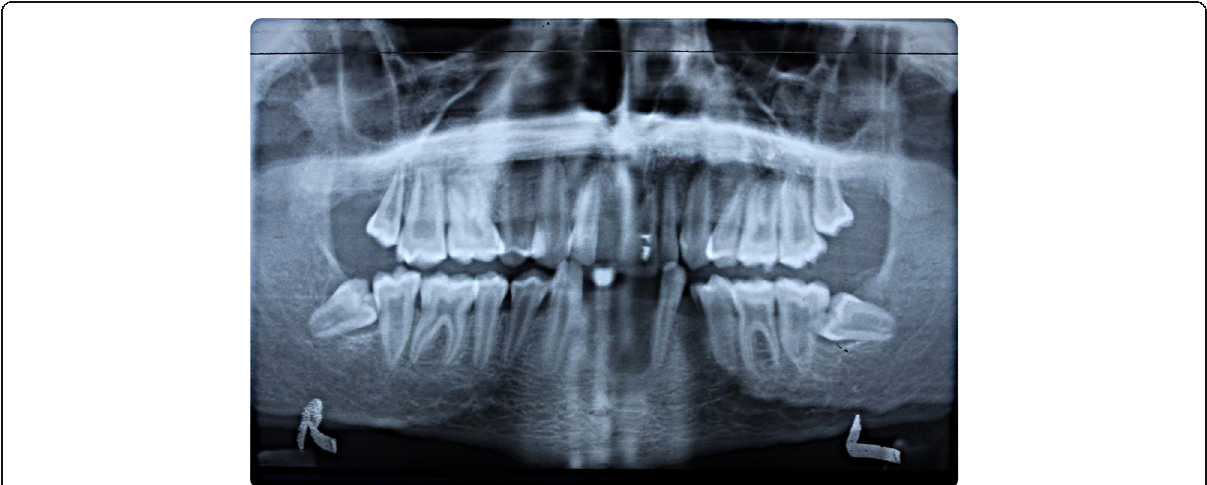
Fig. 2 Pre-operative radiographs. Radiographic situation at presentation